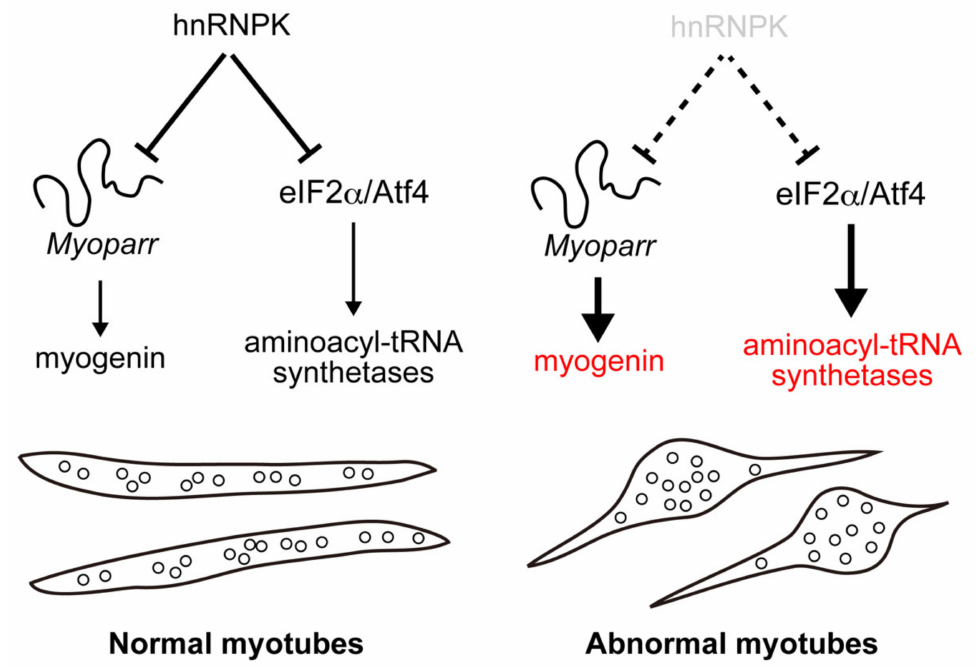
Figure 7. Two different downstream targets of hnRNPK during myogenic differentiation. During myogenic differentiation, hnRNPK has two different downstream targets. One is myogenin , which codes for a regulator of myogenic differentiation. hnRNPK represses the myogenin expression by binding to the ccawmcc motifs on Myoparr . The other target is aminoacyl-tRNA synthetases. hnRNPK regulates the expression of aminoacyl-tRNA synthetases via the eIF2 α /Atf4 pathway. In hnRNPK- depleted cells, the hyperactivated expression of these genes may lead to the locally spherical formation of